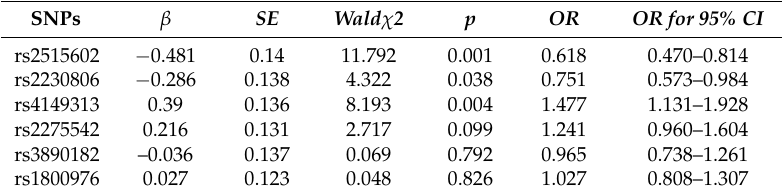
Table 4. The relationship between ABCA1 gene variant and overweight/obese. SNPs β SE Wald χ 2 p OR